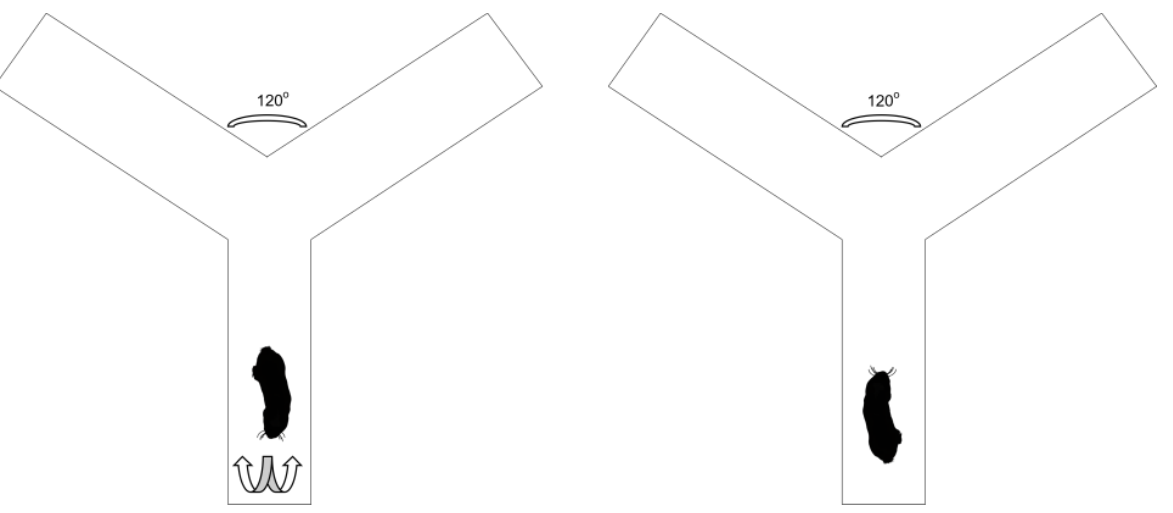
Figure 1. The setup of the Perspex Y-maze, and how individual Damaraland mole rats were placed into the Y-maze facing away from the center and had to make a directional turn in order to reach the middle of the maze. The direction of the turn to reach the middle of the maze was used as the turning bias.